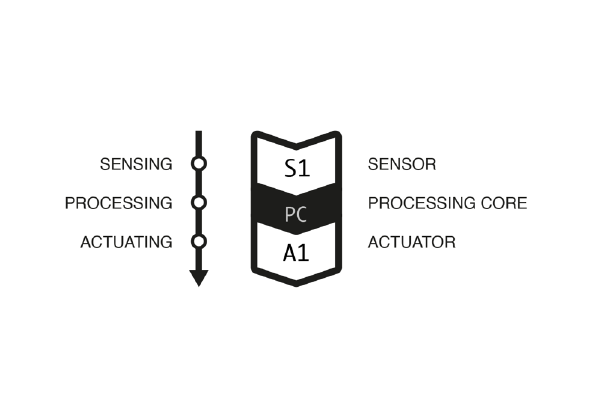
Figure 1 | Actor’s I/O